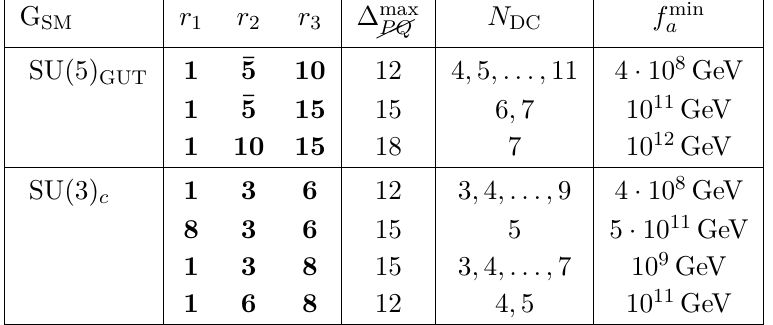
(or equivalently r ), 3 2